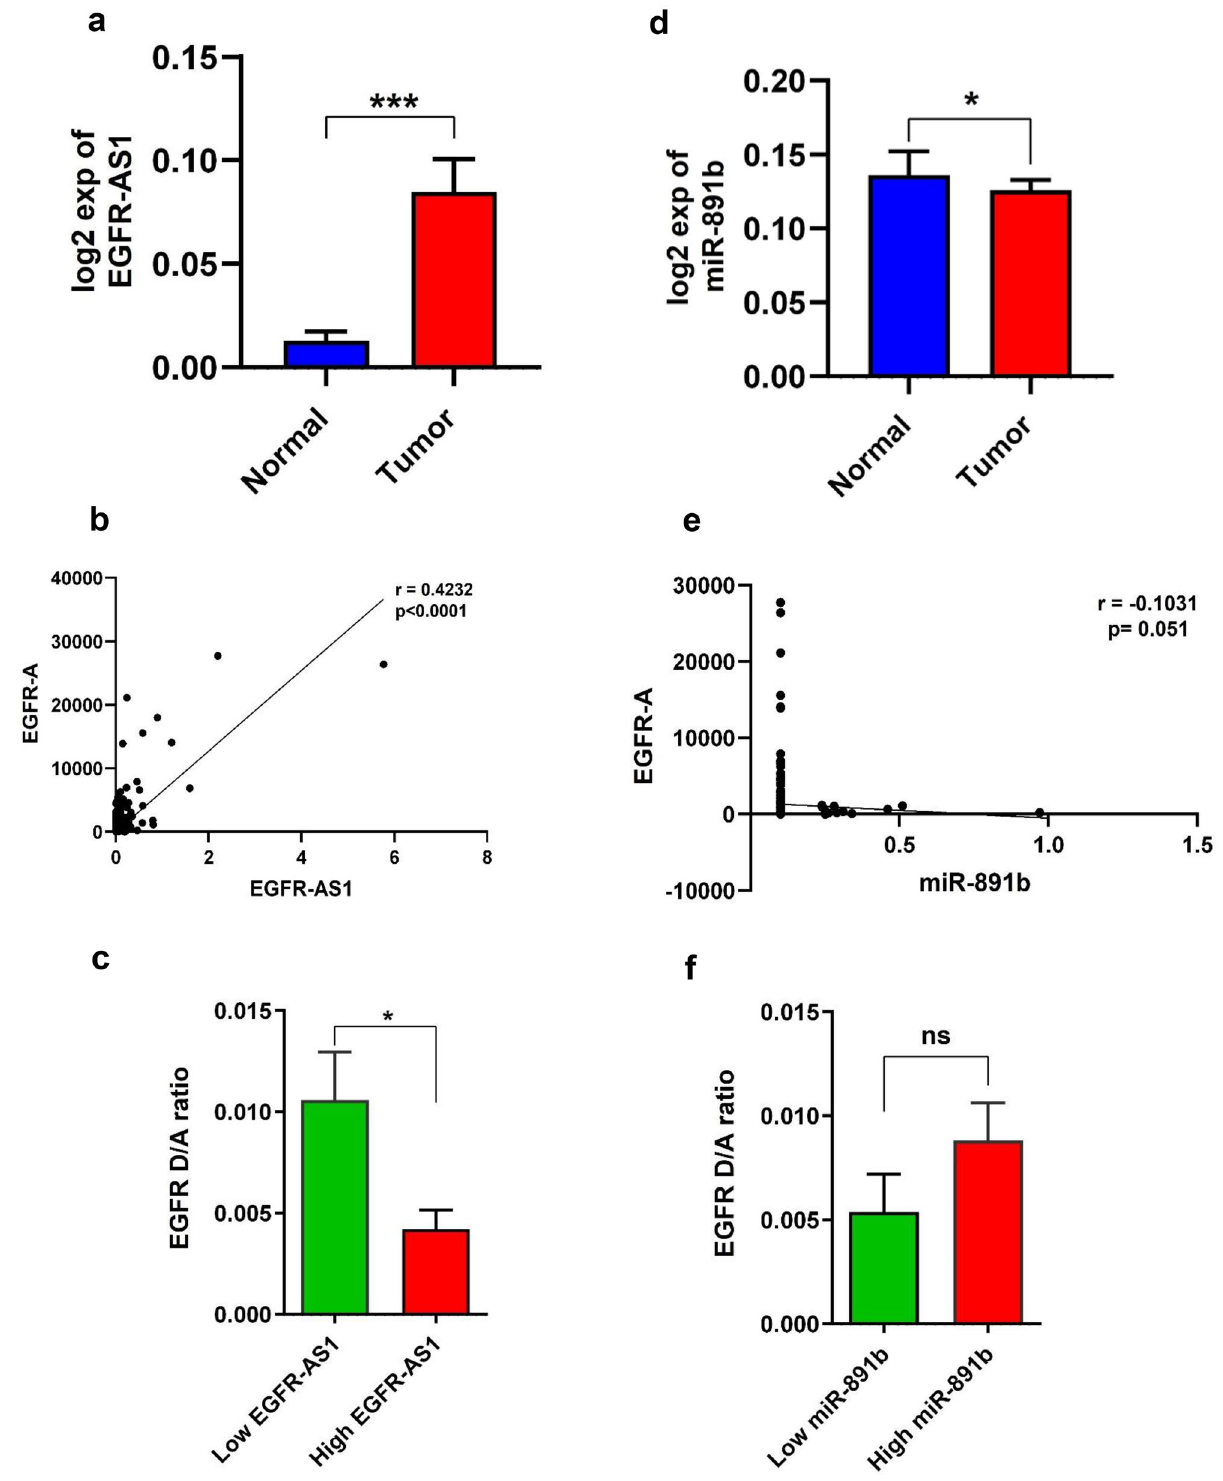
Figure 5. Expression analysis of EGFR A/D, EGFR-AS1 and miR-891b in HNSCC TCGA dataset. ( a ) Graph showing the relative fold change of EGFR-AS1. ( b ) Scatter plot showing the correlation analysis of EGFR-A isoform expression in relation to EGFR-AS1 expression. ( c ) Graph showing the EGFR D/A ratio in relation to low and high EGFR-AS1 expression. ( d ) Graph showing the relative fold change of miR-891b. ( e ) Scatter plot showing the correlation analysis of EGFR-A in relation to miR-891b. ( f ) Graph showing the EGFR D/A ratio in relation to low and high miR-891b expression (Statistical significance represented as * for p-value < 0.01, *** for < 0.001 ns-non significant, two tailed Student’s t-test and Spearman rank correlation